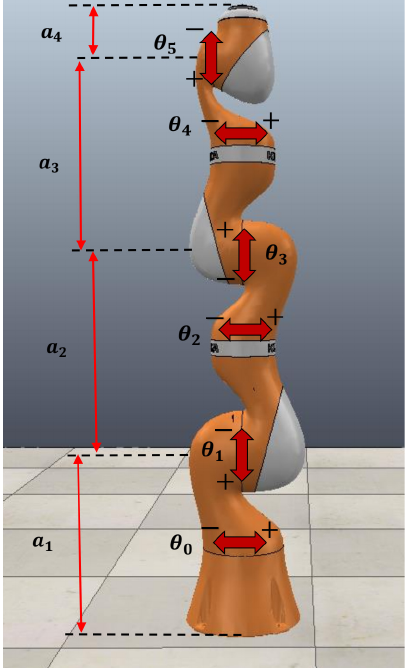
Figure 17. Parameters of the KUKA LBR iiwa 14R820 robot manipulator.